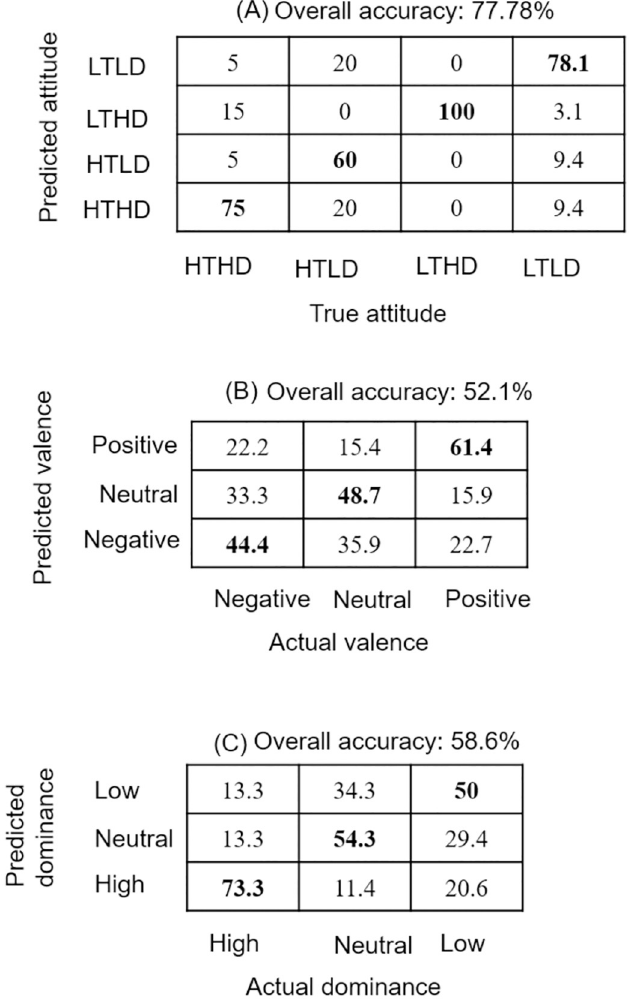
Fig 1. Confusion matrices of p(true attitude | model prediction) for each SVM. (A) Results of vocal classification for different attitudinal labels. with a 77.8% accuracy. From bottom left to top corner right are all the congruent classifications (HTHD: trustworthy/dominant, HTLD: trustworthy/non-dominant, LTHD: untrustworthy/dominant, LTLD: untrustworthy/non-dominant). True attitude represents the given class label, and predicted attitude is the assigned class label after supervised learning. (B) Results of vocal classification for valence (positive, negative or neutral). (C) Results of vocal classification for dominance (high, low or neutral), from bottom left corner to top right are all the correctly classified items (Low Dominance = 50%; neutral = 54.3%, high dominance = 73.3%).